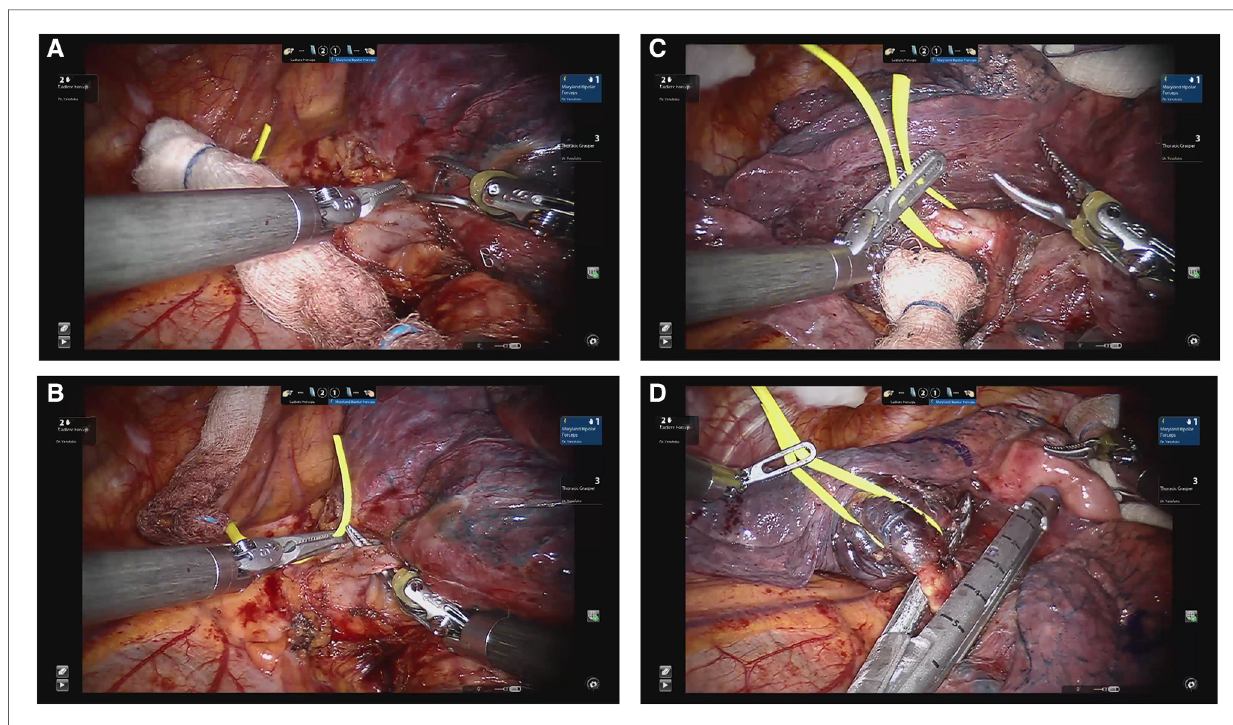
FIGURE 4 Lingulectomy. ( A ) Dissection of lingular vein. ( B ) Encircling lingular vein. ( C ) Dissection of lingular PA branches. ( D ) Division of lingular